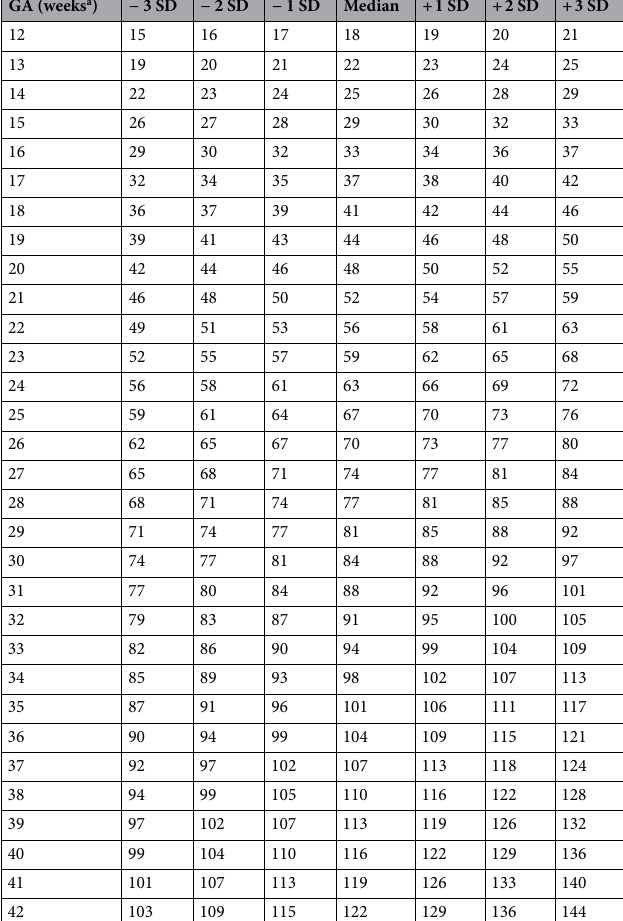
Table 6. Estimated mean abdominal diameter (MAD) in mm by gestational age (GA) for males and females, standard deviations (SD). a GA expressed as completed gestational weeks, e.g. 12 weeks corresponds to 12 + 0 weeks or 84 gestational